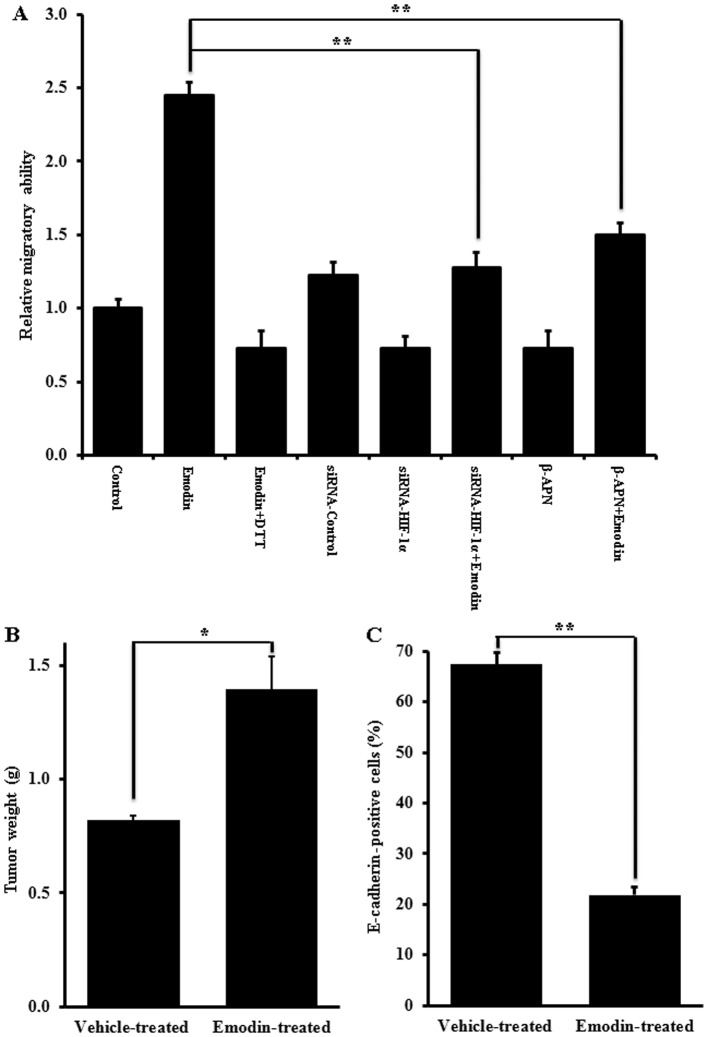
Effect of ROS on SKOV-3 cell migration in vitro, tumorigenicity and E-cadherin expression in vivo. (A) Relative motility of the SKOV-3 cells under the indicated treatments. Cell migration was assessed by counting the number of cells that had migrated across the scratch. The number of migrated cells was normalized to the scratch area and are expressed as a fold-change relative to the untreated control. Values are means ± SD, n=3. **P<0.01. (B) Tumor weight at the end of 12 weeks after i.p. inoculation of 106 SKOV-3 cells into nude mice. Treatment of the mice commenced on day 3 post-inoculation with an i.p. injection of 2.5 g/kg or saline for 3 weeks. (C) Immunohistochemical quantification of E-cadherin-positive cells in the peritoneal tumors when all the mice were sacrificed 12 weeks after inoculation. *P<0.05, **P<0.01. ROS, reactive oxygen species.